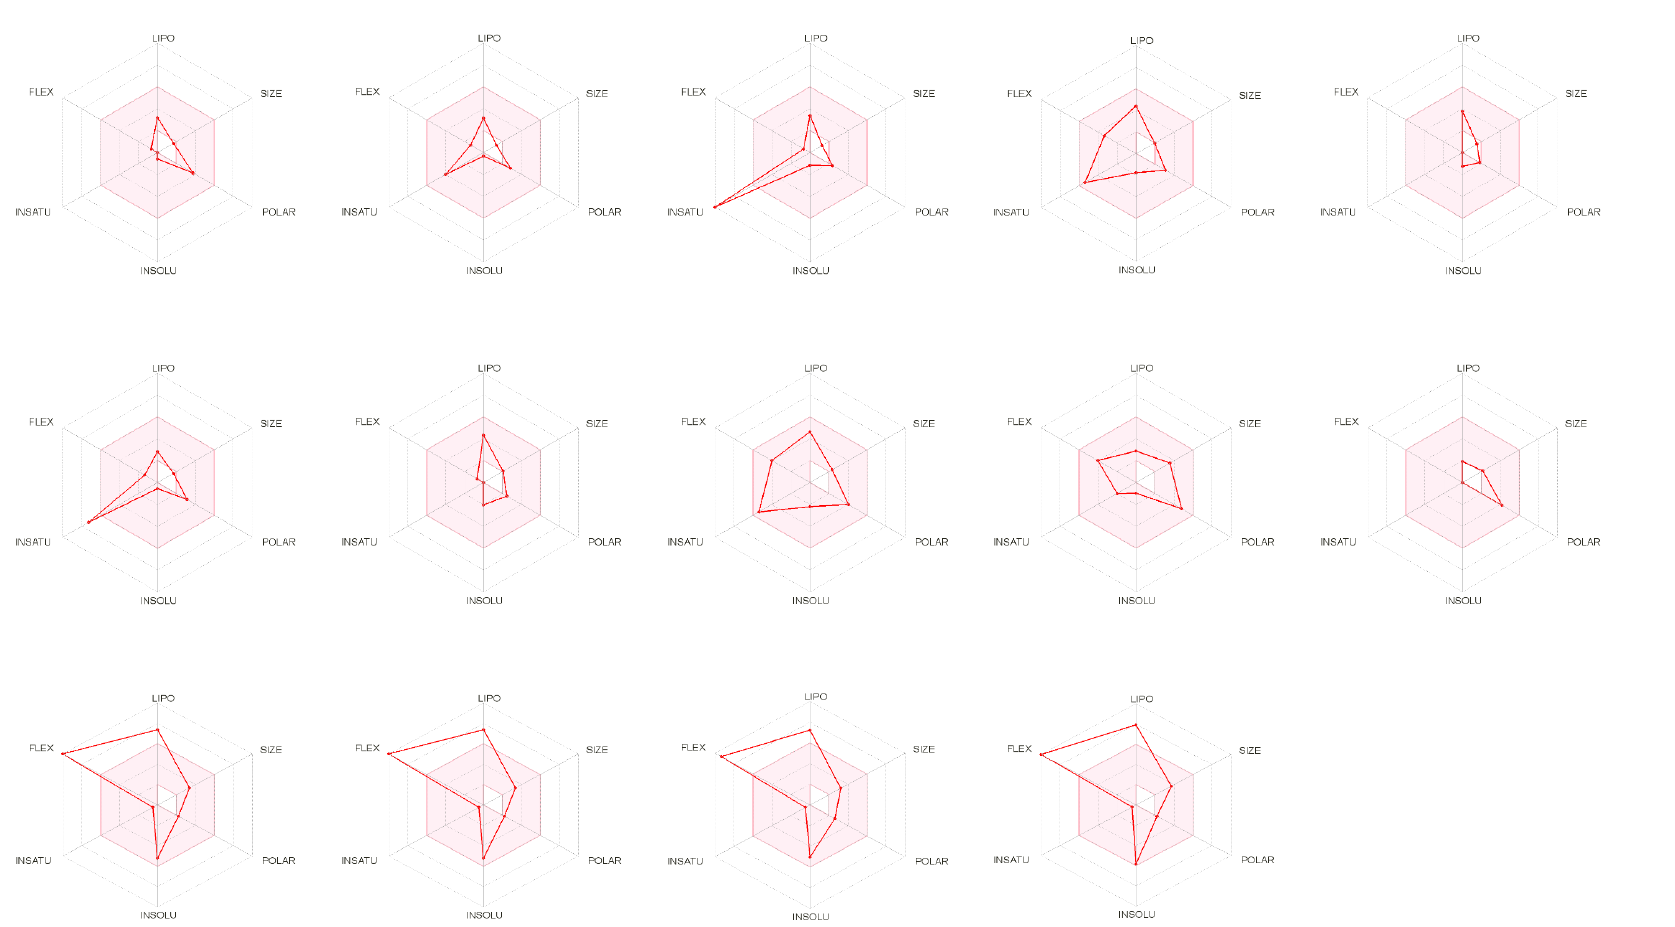
Figure 2. Bioavailability radar of identified compounds based on the physicochemical indices ideal for oral bioavailability. LIPO, lipophilicity: −0.7 < XLOGP3 < þ 5; SIZE, molecular size: 150 g/mol < molecular weight < 500 g/mol; POLAR, polarity: 20 Å2 < TPSA (Topological Polar Surface Area) < 130 Å2; INSOLU, insolubility: 0 < Log S (Insolubility in water: ESOL) < 6; INSATU, Insaturation: 0.25 < Fraction of carbons in the sp3 hybridization < 1; FLEX, flexibility: 0 < the number of rotatable bonds < 9. The colored zone is the suitable physicochemical space for oral bioavailability.